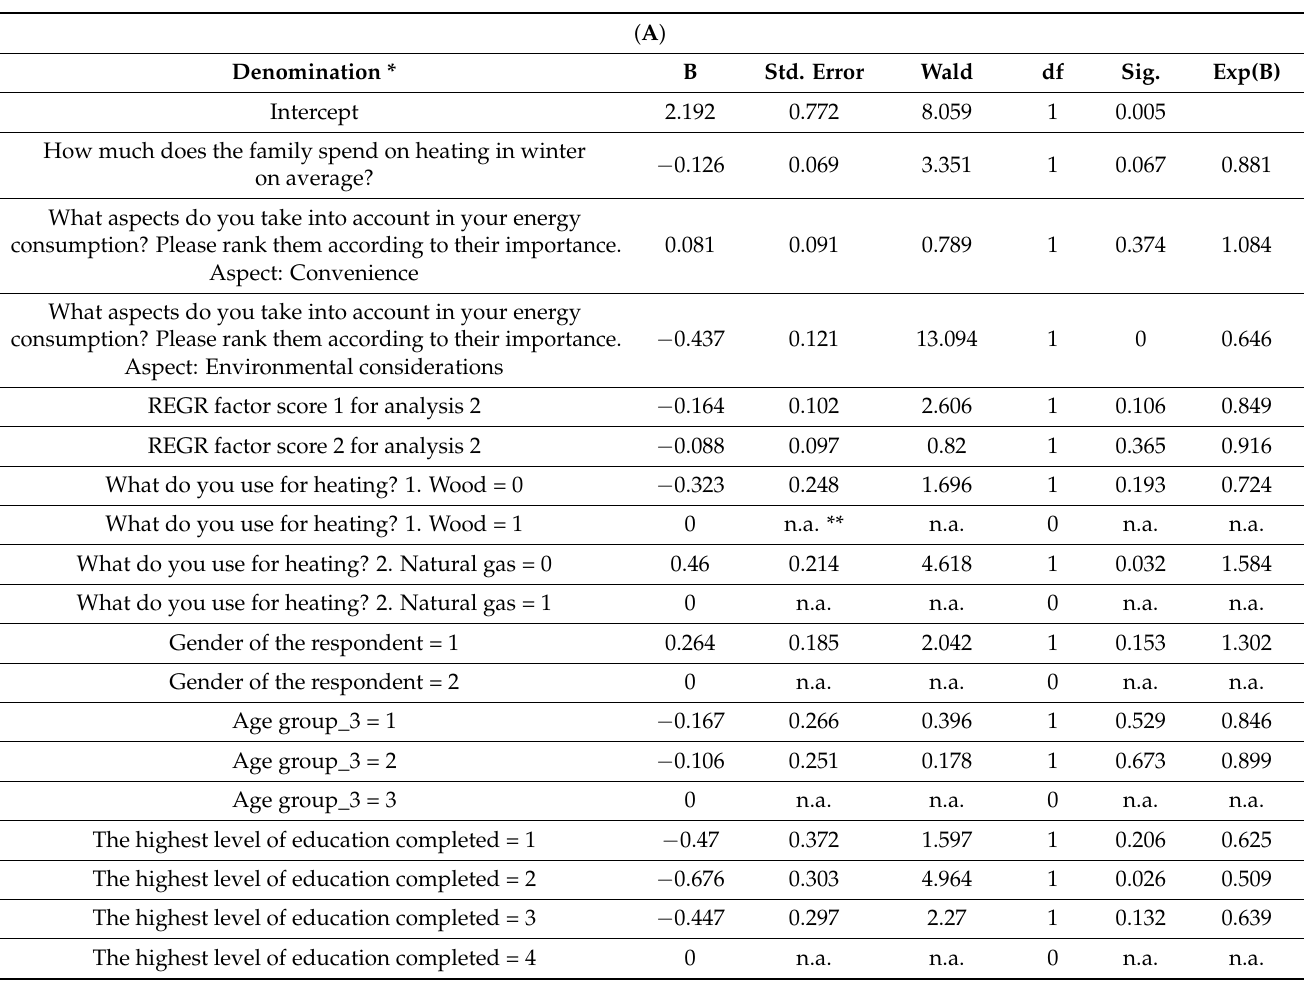
Table 11. ( A ) Part 1: Ordinary Logit Model for the examination of both the convenient and the environment-friendly attitude compared to the convenient attitude. ( B ) Part 2: Ordinary Logit Model for the examination of preference for environment-friendly attitude compared to the convenient